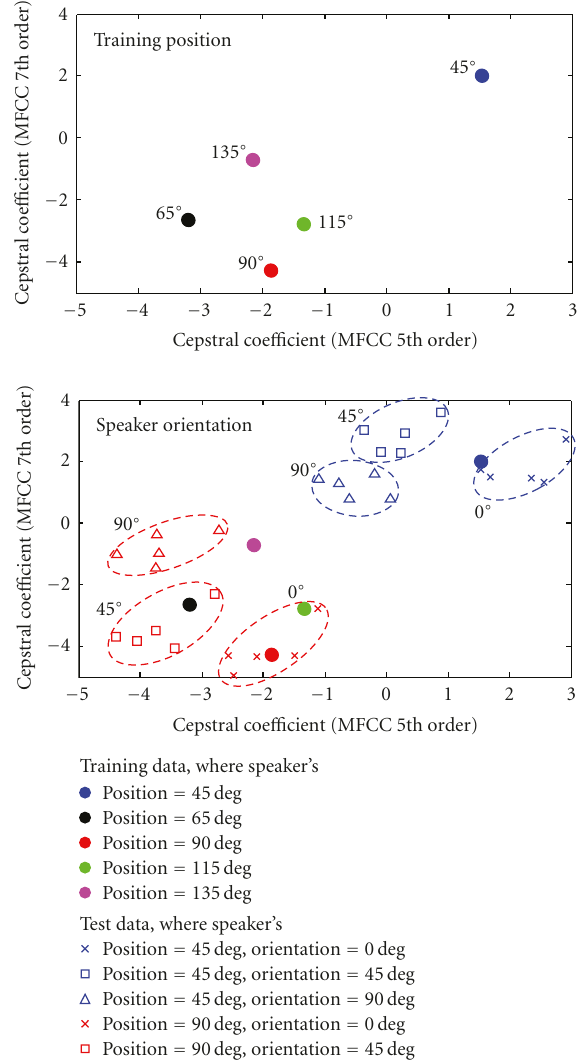
Figure 15: Mean acoustic transfer function values for five positions (top graph) and mean acoustic transfer function values for three speaker orientations (0deg, 45deg, and 90deg) at a position of 45deg and 90deg (bottom